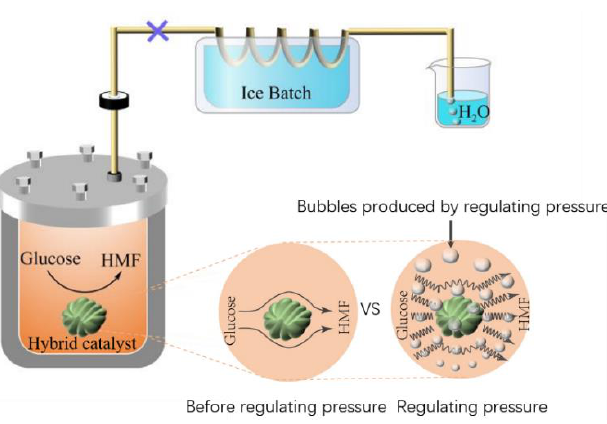
Figure 7. Mechanism of pressure reduction to enhance catalytic efficiency.